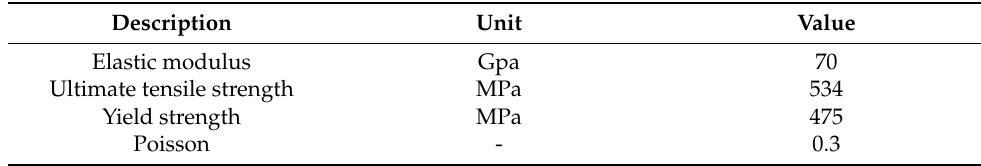
Table 2. Mechanical properties of aluminium alloy 7050.